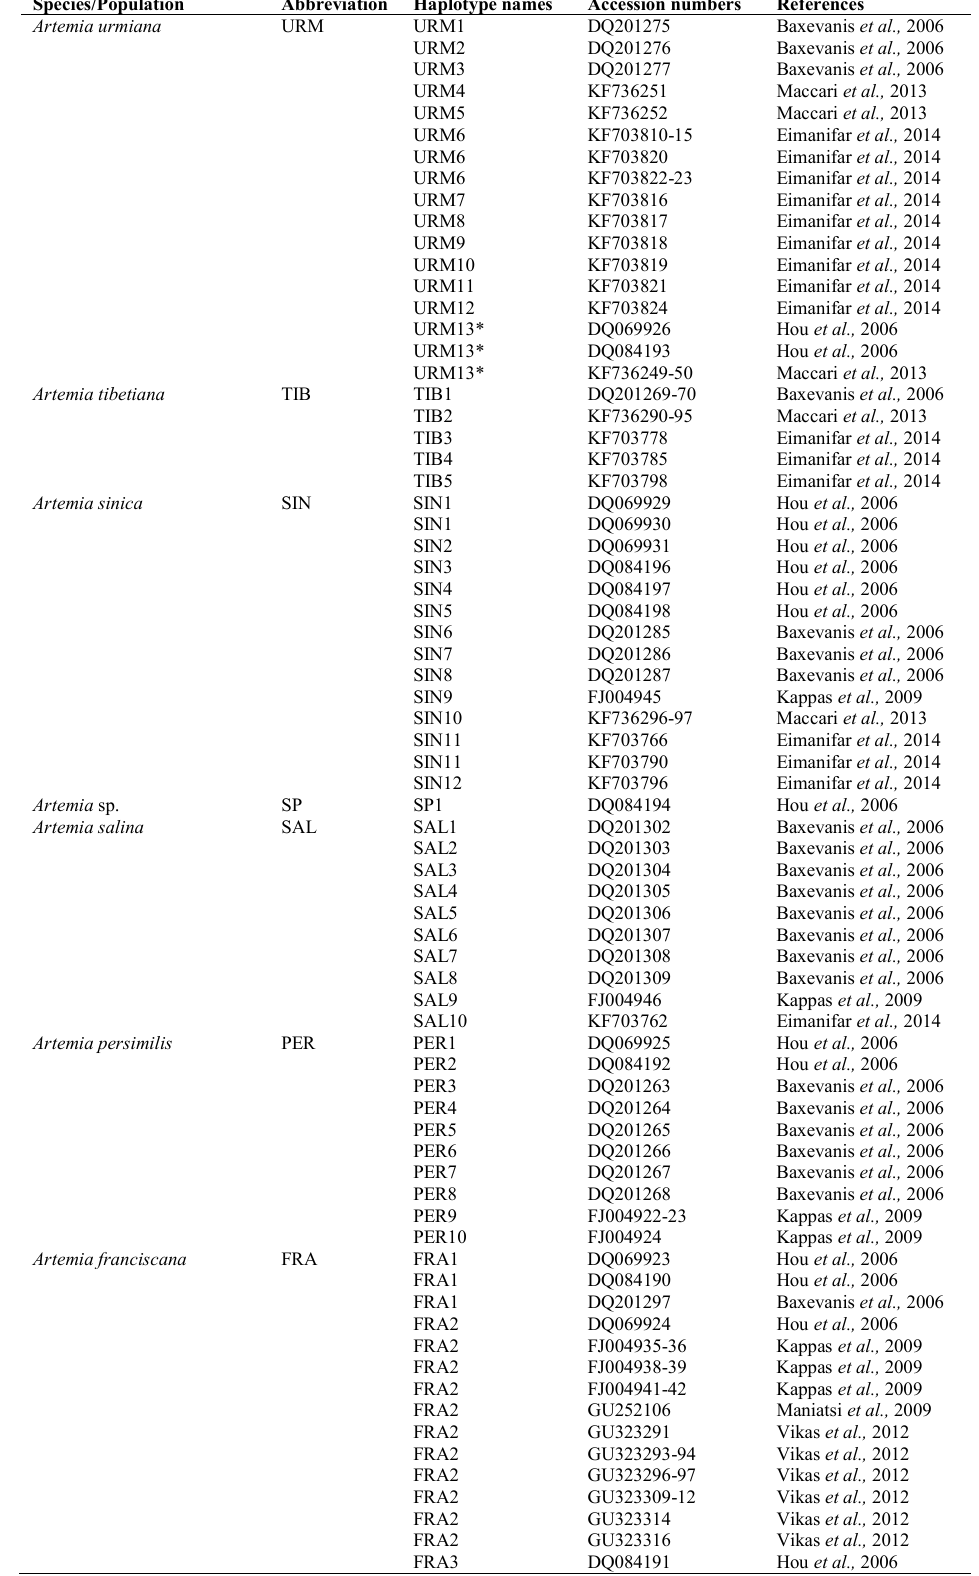
Table 1. Sampling information of Artemia specimens/sequences (all downloaded from GenBank) used in the present